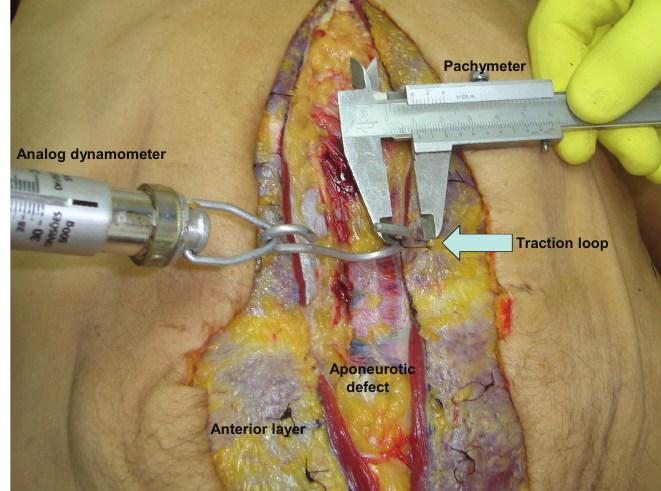
FIGURE 3 - Measurement of the tensile